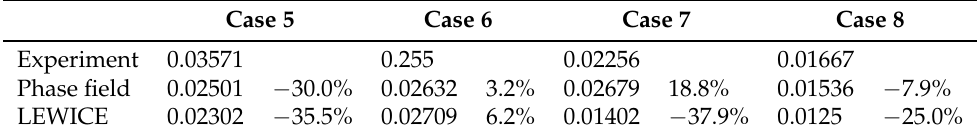
Figure 9. Comparison of the ice shapes in verification cases from Case 5 to Case 8. Table 3. Stagnation thickness of ice shapes provided from Case 5 to Case